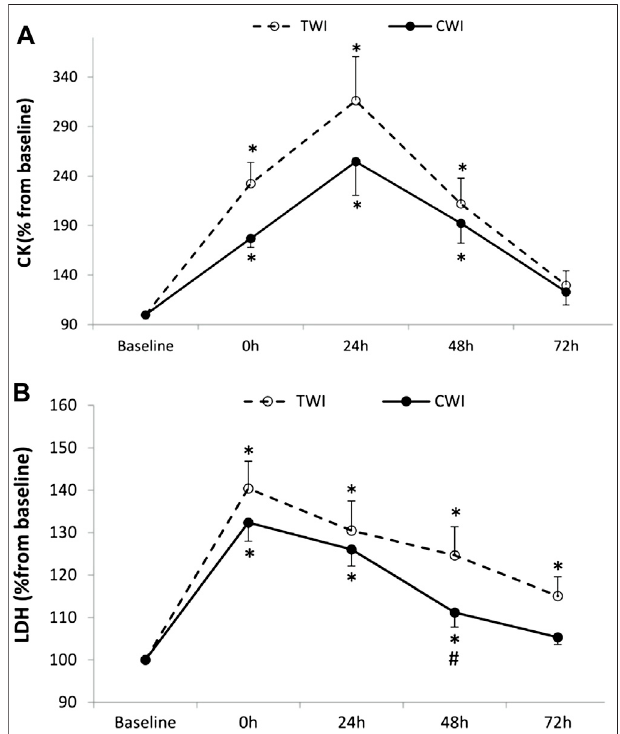
FIGURE4| Plasmacreatinekinase(CK) (A) andLactatedehydrogenase (LDH) (B) collected at baseline and following the match (post, 24h, 48h and 72 h) after cold water immersion (CWI) or thermoneutral water immersion (TWI). *Signi fi cant difference in comparison to baseline ( p < 0.05). # Signi fi cant difference in comparison to TWI ( p <